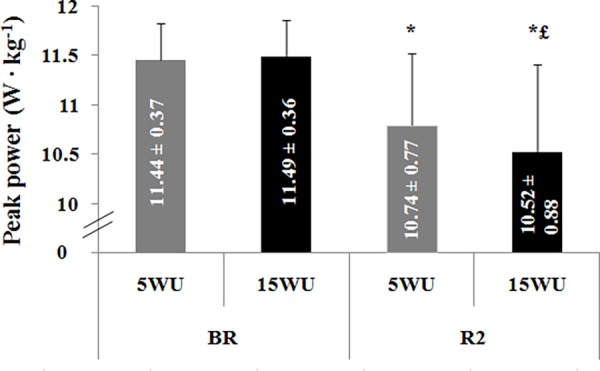
Peak power (W ∙ kg−1) (mean ± SD, n = 12) determined during the 30-second Wingate test, after the 5-minute (5WU) and the 15-minute (15WU) warm-up, before (BR) and during (R2) Ramadan.*: significant difference in comparison with BR. £: significant difference in comparison with the 5-minute warm-up.